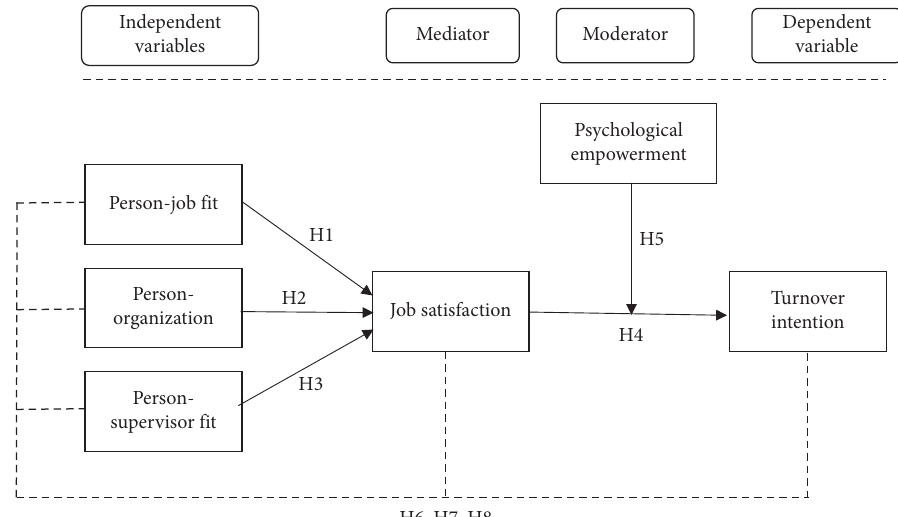
Figure 1: Research